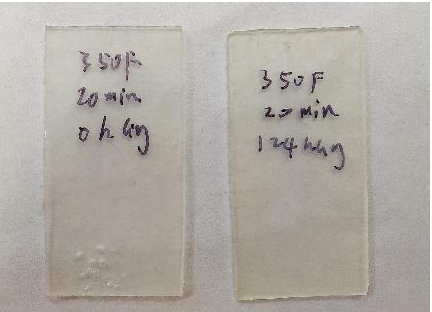
Table 2. Mass loss ratio (MLR) for 124 kGy resin tested at 177 ℃ for 20 min.